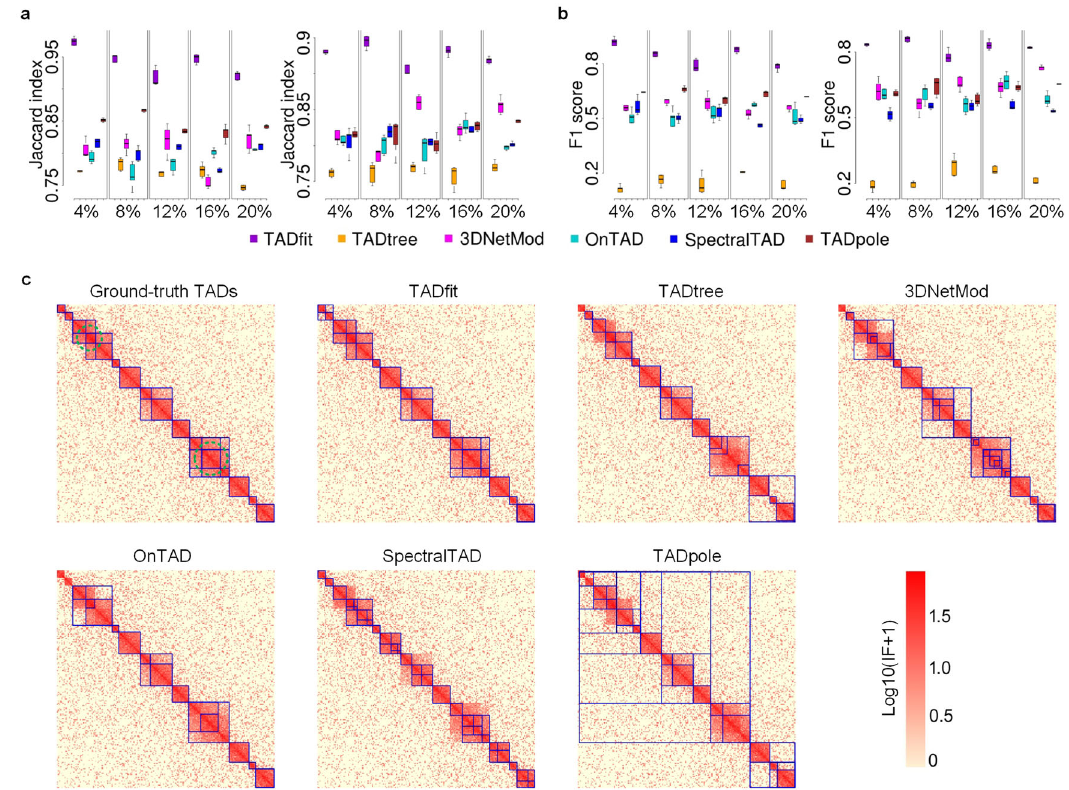
Fig. 2 Performance comparison on simulated Hi-C data. TAD fi t and the other fi ve methods, including TADtree, 3DNetMod, OnTAD, SpectralTAD, and TADpole, were compared on simulated Hi-C data. Simulated contact matrices were fed into these methods individually, the called TADs on each contact matrix were compared with ground-truth TADs to obtain a set of Jaccard indexes and F1 scores. Boxplots of a Jaccard index and b F1 score on simulated contact matrices with (left) and without (right) partially overlapping TADs at fi ve different noise levels (4%, 8%, 12%, 16%, 20%) were given. The center line of the box indicates the median, whereas the bottom and top of the box indicate the fi rst and third quartiles, respectively, and whiskers are extended to the most extreme data point that is no more than 1.5 × interquartile range from the bottom and top of the box. Besides, c heatmaps of a simulated contact matrix (ChrS_MAT_noise0.20_POP0.15_rep1, bin 1 – bin 200 out from a total of about 400 bins) and the TADs called by different methods on it were shown. These heatmaps were drawn on a log scale, the ground-truth TADs as well as the TADs called by TAD fi t and the other fi ve methods were outlined with blue solid lines, and the partially overlapping TADs were marked with a green dotted circle on the fi rst